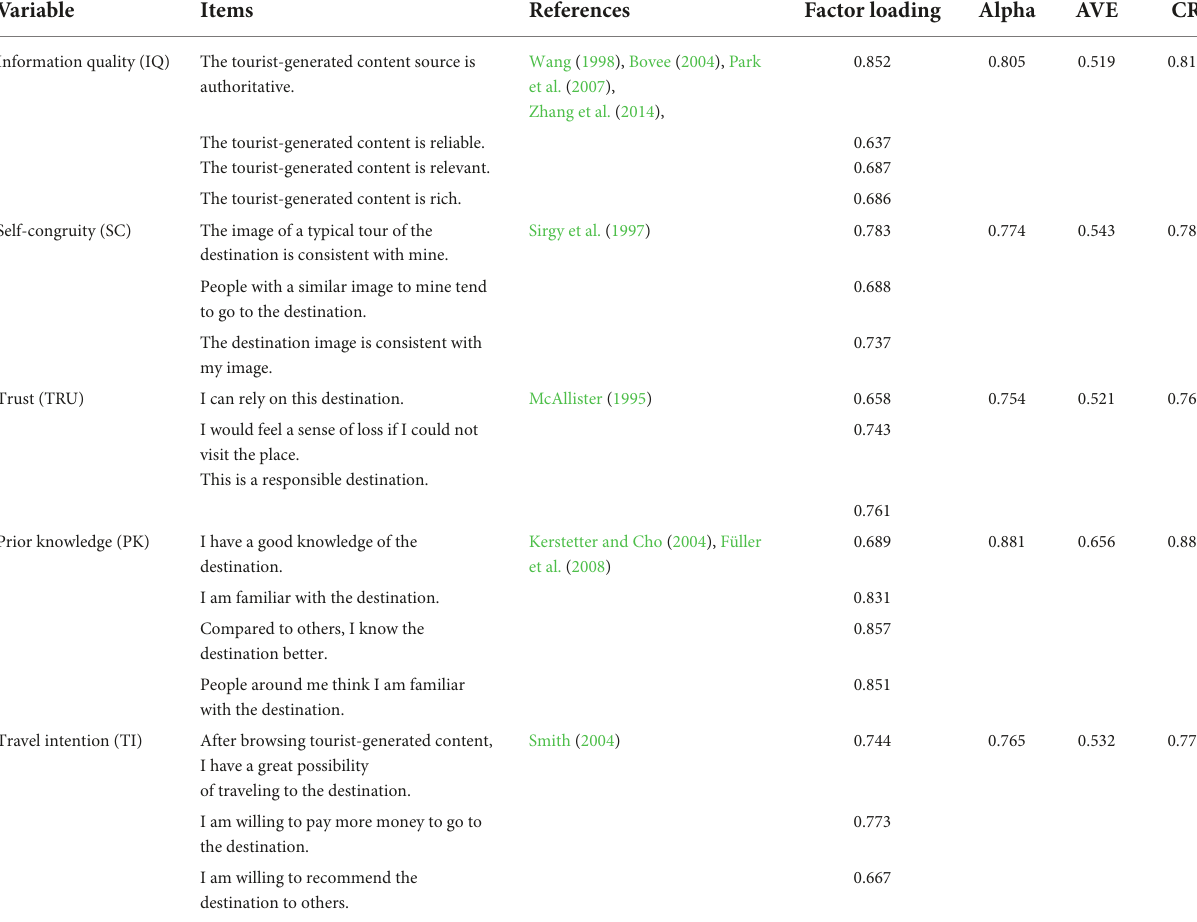
TABLE 2 Construct reliability and convergent